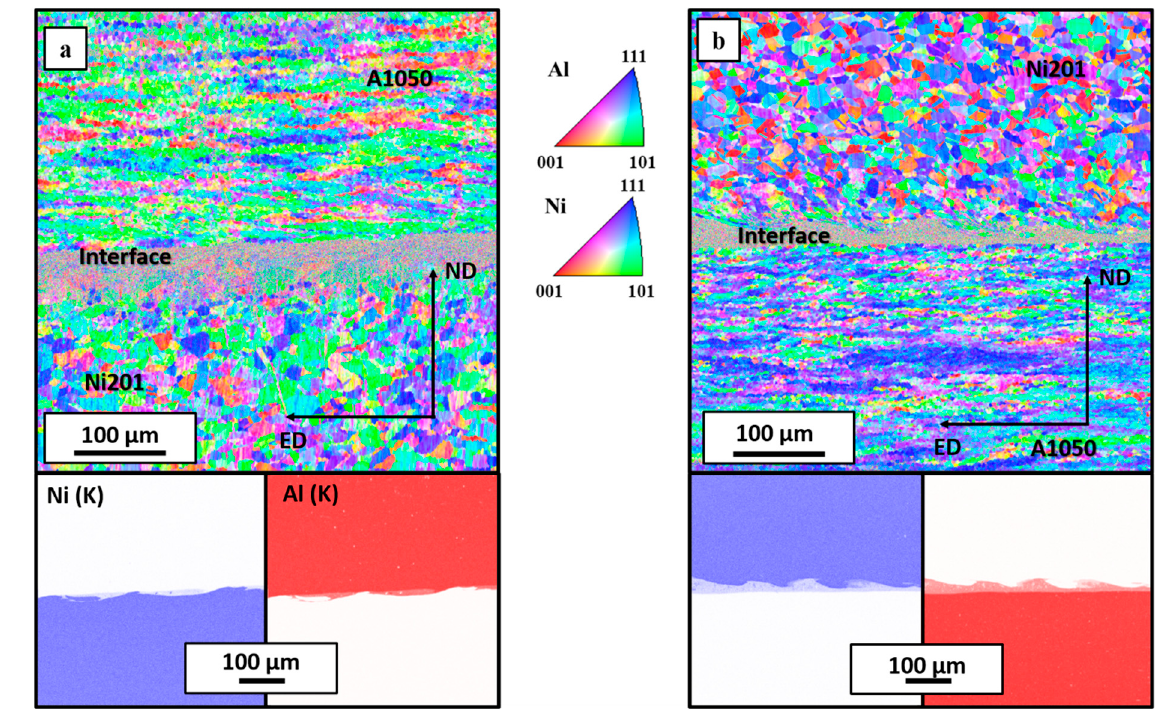
Figure 5. EBSD maps and EDS elemental distribution maps of Al (K) and Ni (K) of the explosively welded clads’ interfaces and adjacent regions obtained using 2000 m/s ( a ) and 2800 m/s detonation velocity ( b ).